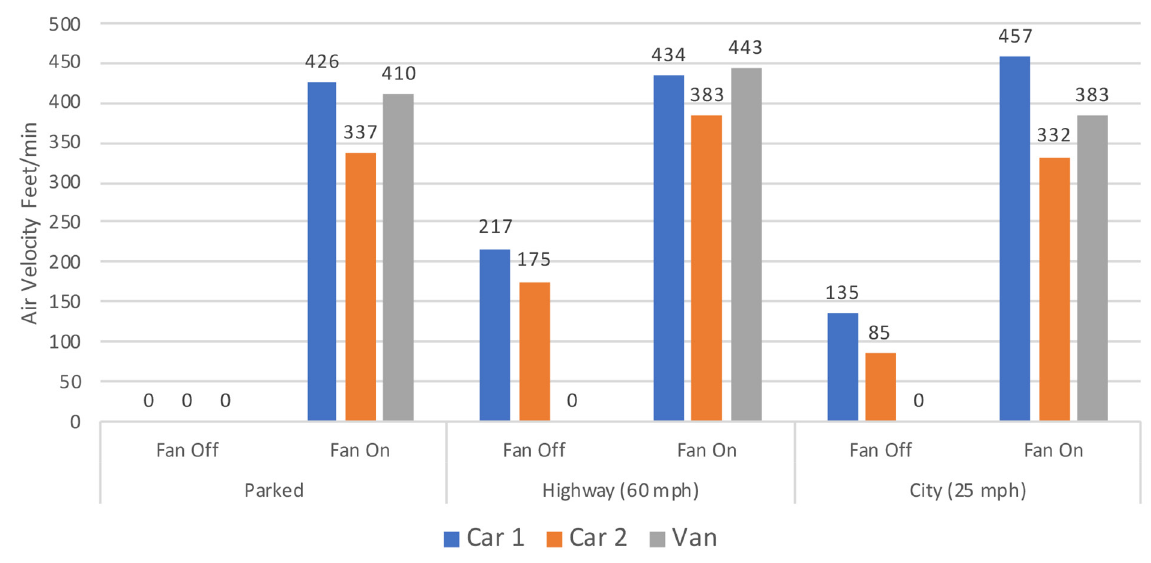
Figure 4. Measured airflow from the front vents for 3 test vehicles under varying driving